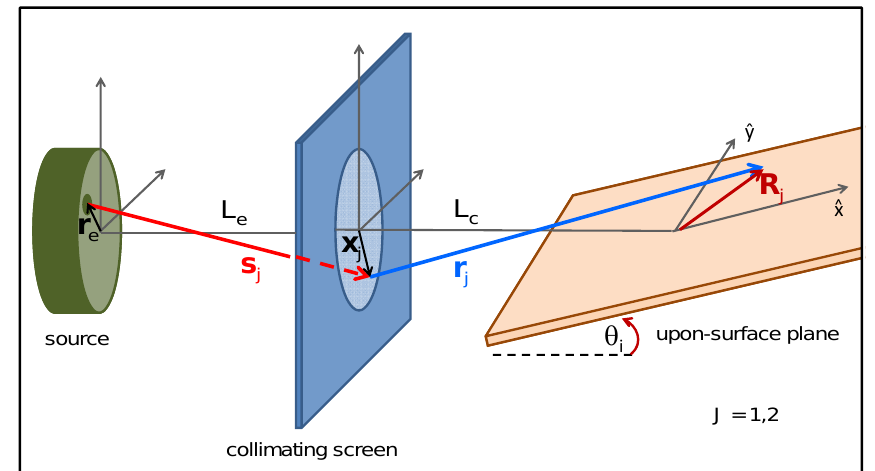
Figure A1. Depiction of the collimating scheme considered in the Appendix, together with the involved